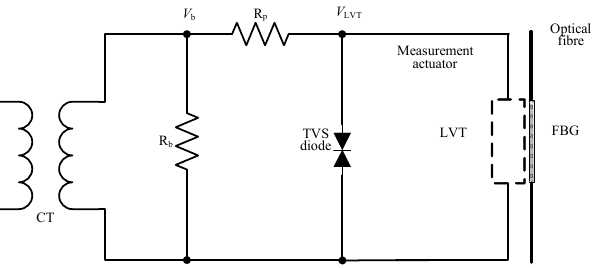
Figure 1. Electrical arrangement for connecting LVT to CT terminals.